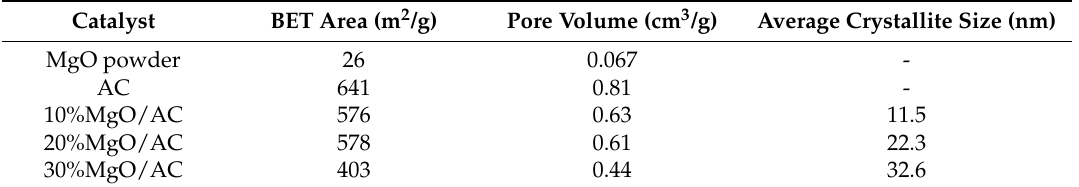
Table 1. BET (Brunauer, Emmett, Teller) surface area, total pore volume, and average crystallite size for MgO/AC supported